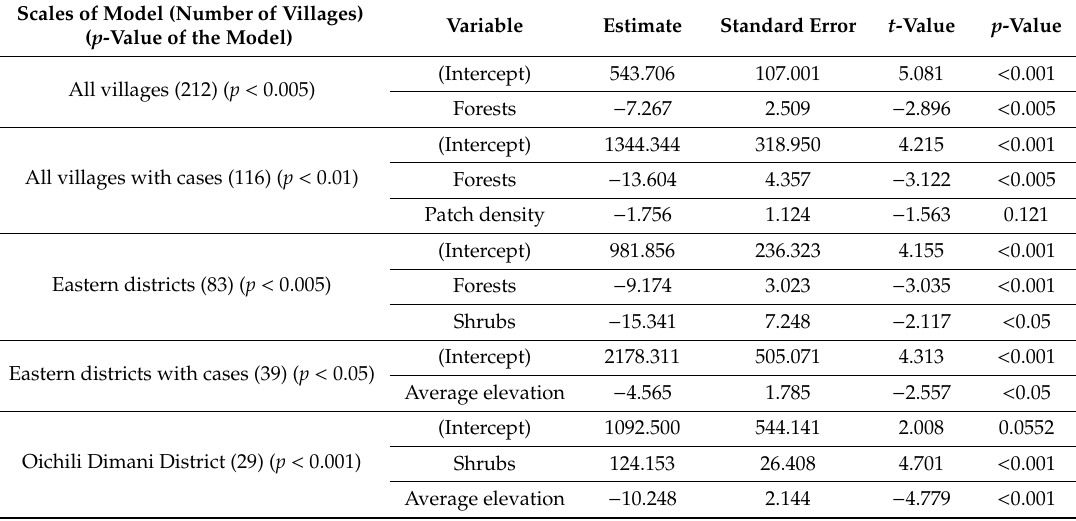
Table 3. Results of multiple linear regression at di ff erent scales (only significant regressions are shown). Scales of Model (Number of Villages) Variable Estimate Standard Error t -Value p -Value ( p -Value of the Model) (Intercept) 543.706 107.001 5.081 < 0.001 All villages (212) ( p < 0.005) Forests − 7.267 2.509 − 2.896 < 0.005 (Intercept) 1344.344 318.950 4.215 < 0.001 All villages with cases (116) ( p < 0.01) Forests − 13.604 4.357 − 3.122 < 0.005 Patch density − 1.756 1.124 − 1.563 0.121 (Intercept) 981.856 236.323 4.155 < 0.001 Forests − 9.174 3.023 − 3.035 < 0.001 Shrubs − 15.341 7.248 − 2.117 < 0.05 (Intercept) 2178.311 505.071 4.313 < 0.001 Average elevation − 4.565 1.785 (Intercept) 1092.500 544.141 2.008 0.0552 Shrubs 124.153 26.408 4.701 < 0.001 Average elevation − 10.248 2.144 − 4.779 <